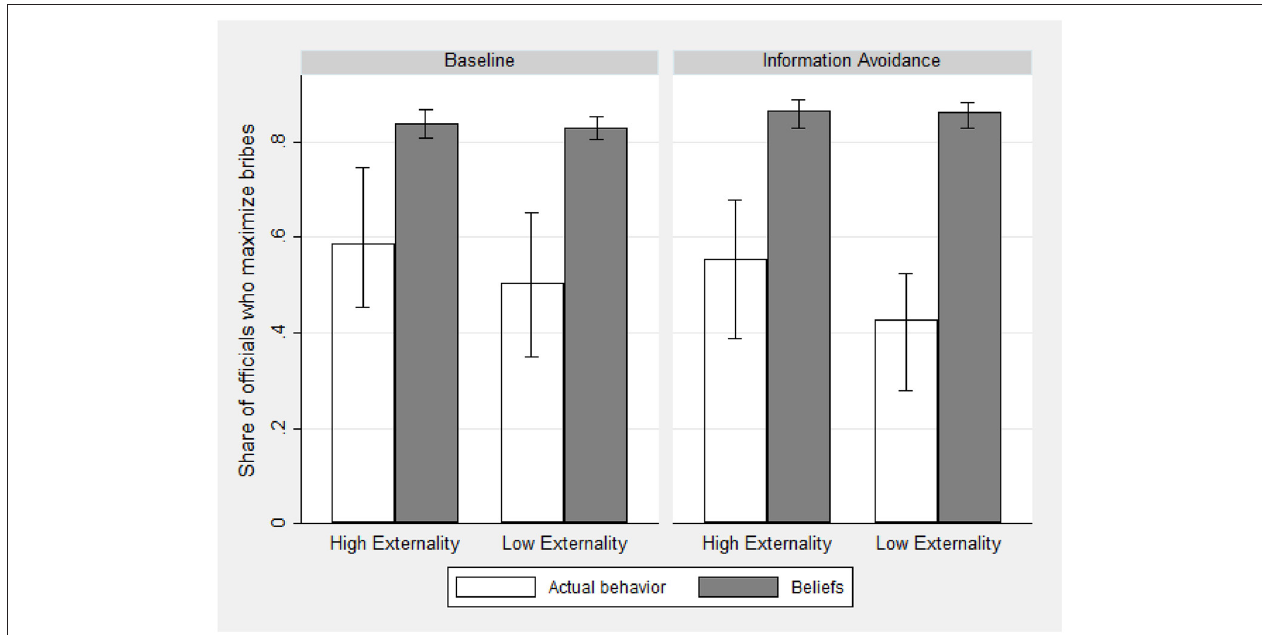
FIGURE 3 | Bribe maximization: Beliefs vs. actual behavior, by